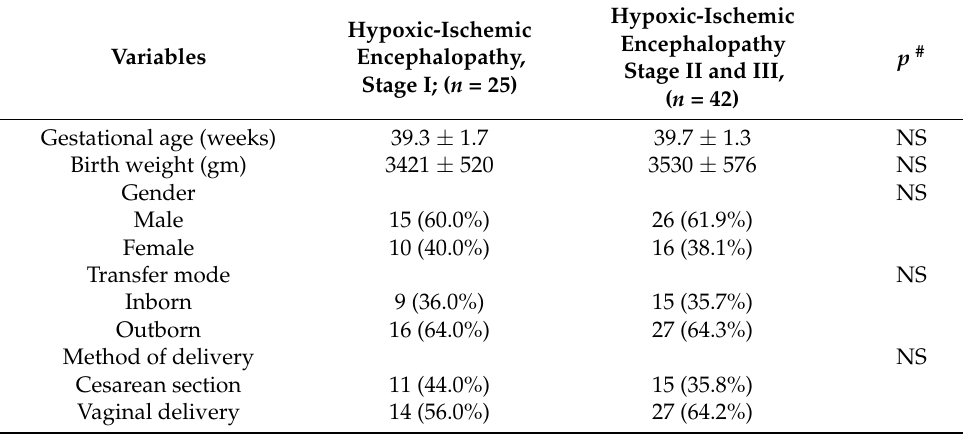
Table 1. Demographic data of 67 newborns with HIE.